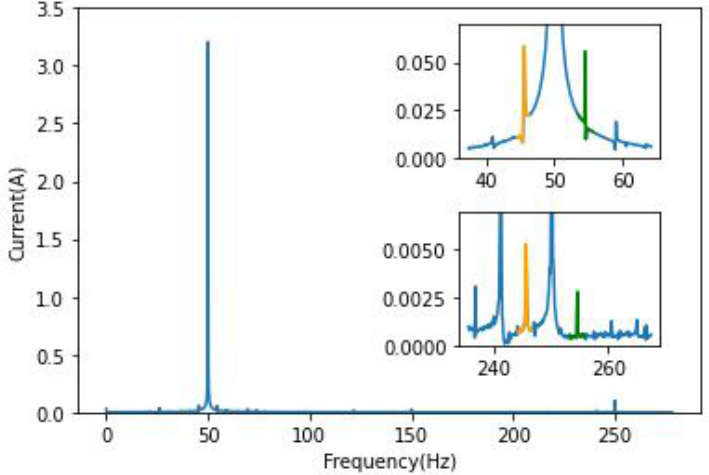
Figure 4. FFT phase current of 2 BRB IM/Zoom around 50 and 250